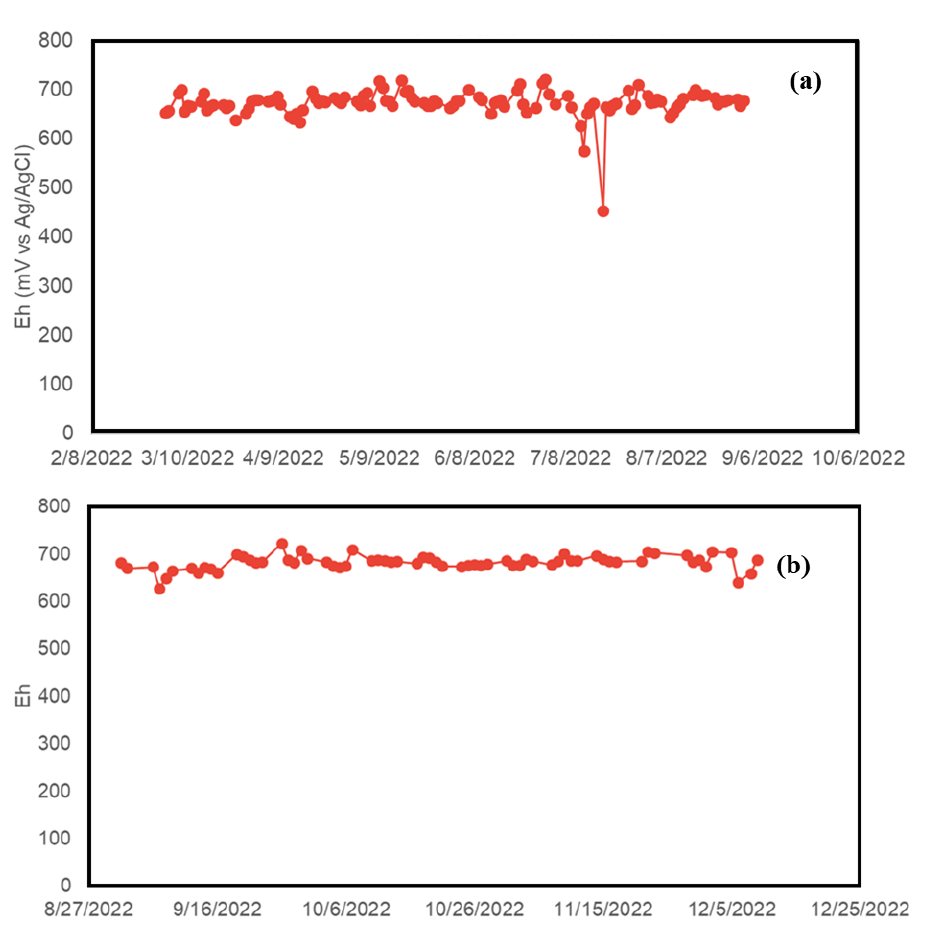
Figure 5. Comparison of Eh data in the WBB 419 bioreactor: ( a ) from 3 March 2022 to 31 August 2022. ( b ) from 9 January 2022 to 12 September 2022.